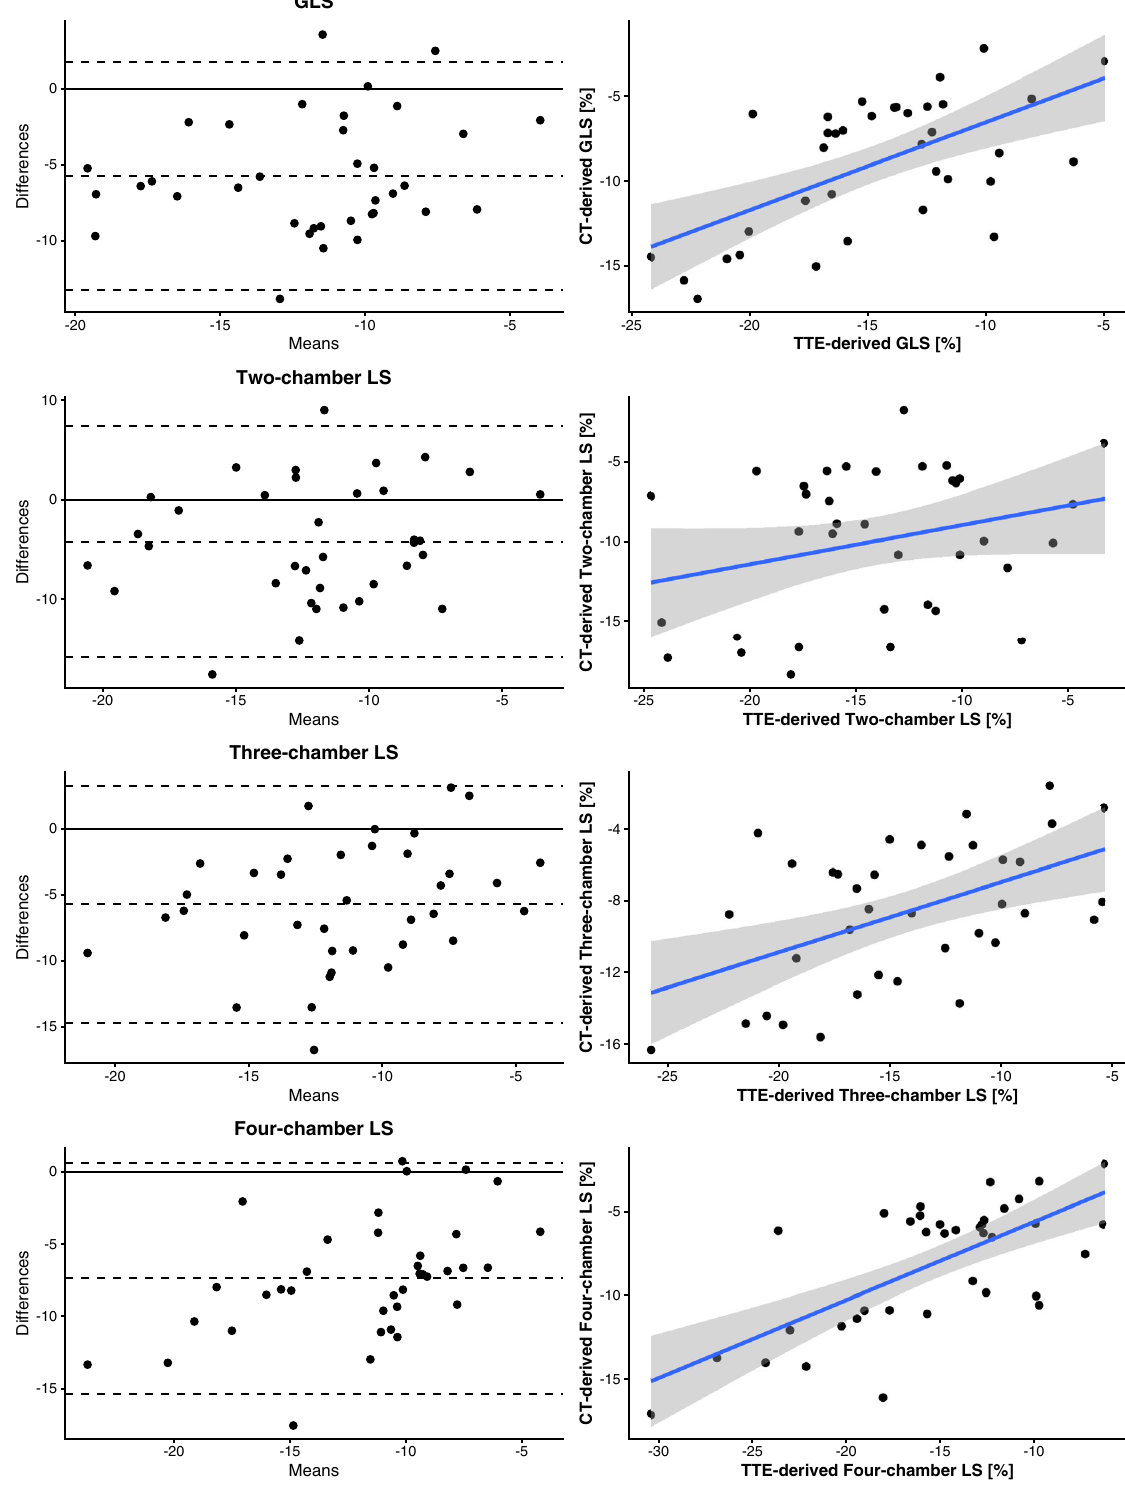
Figure 4. Scatterplots and Bland–Altman plots of global longitudinal strain as well as longitudinal strain in the two-, three- and four-chamber view. The Pearson’s correlation coefficient was as follows: global longitudinal strain: r = 0.60, p < 0.001; two-chamber view: r = 0.28, p = 0.0929; three-chamber view: r = 0.51, p = 0.0014; four- chamber view: r = 0.69, p < 0.001. (GLS, global longitudinal strain; LS, longitudinal strain; TTE, trans-thoracic